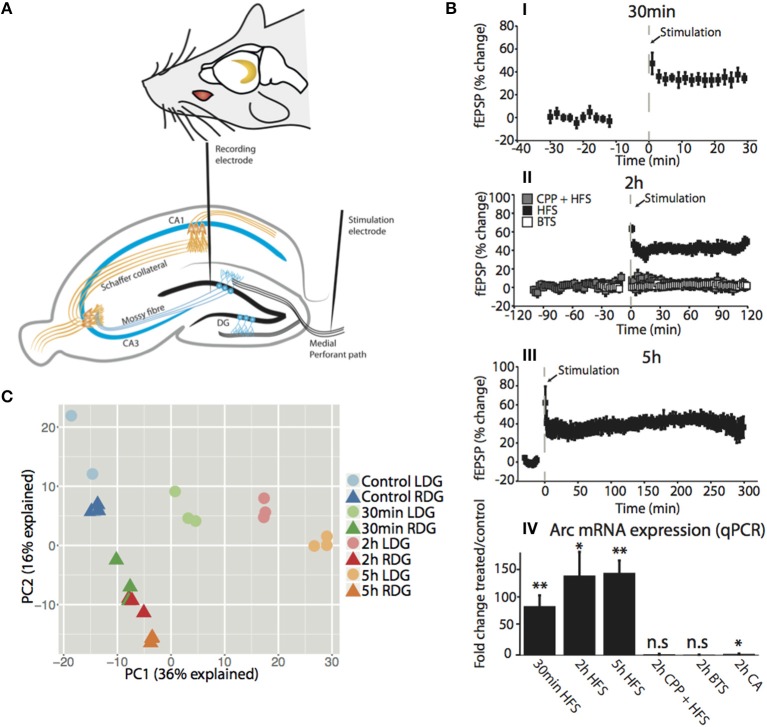
Time dependent high frequency stimulation is the main driver of variation between dentate gyrus samples in vivo. (A) (top) Location of the hippocampus in both hemispheres of the brain. (bottom) Transverse section of the rat brain showing the hippocampal trisynaptic circuitry and the position of the stimulation electrode at the medial performant path and the registration electrode in the middle molecular layer of the dentate gyrus. (B) (I–III) Time course plot showing changes in the medial performant path-evoked fEPSP slope expressed as percentage of baseline. Experimental groups received HFS alone, HFS in the presence of NMDA receptor antagonist CPP, or only baseline test stimuli (BTS). CPP was injected IP at the dose of 10 mg/ml, 90 min prior to HFS. Dentate gyrus tissue was collected at the indicated time points post-HFS (I) 30min-HFS (II) 2h-HFS, 2h-CPP + HFS, 2h-BTS (III) 5h-HFS. Values are means (±s.e.m.) (IV) Quantitative PCR was used to validate the expression of the IEG Arc mRNA in the dentate gyrus (treated/control). PCR was performed in triplicate and normalized to the geometric mean of three housekeeping genes. Values are means (±s.e.m.), n = 5 in all groups except BLS and 30 min-HFS n = 4, * denotes p < 0.05, **denotes p < 0.01; students paired t-test. (C) PCA plot showing the difference between the samples for the first two compartments with the amount of variation explained in the axis. Circles represent the stimulated dentate gyrus (LDG) while triangles represent the unstimulated contralateral side (RDG). The color of each time point is matched for ipsilateral (light) and contralateral (dark) side of the HFS hippocampus.